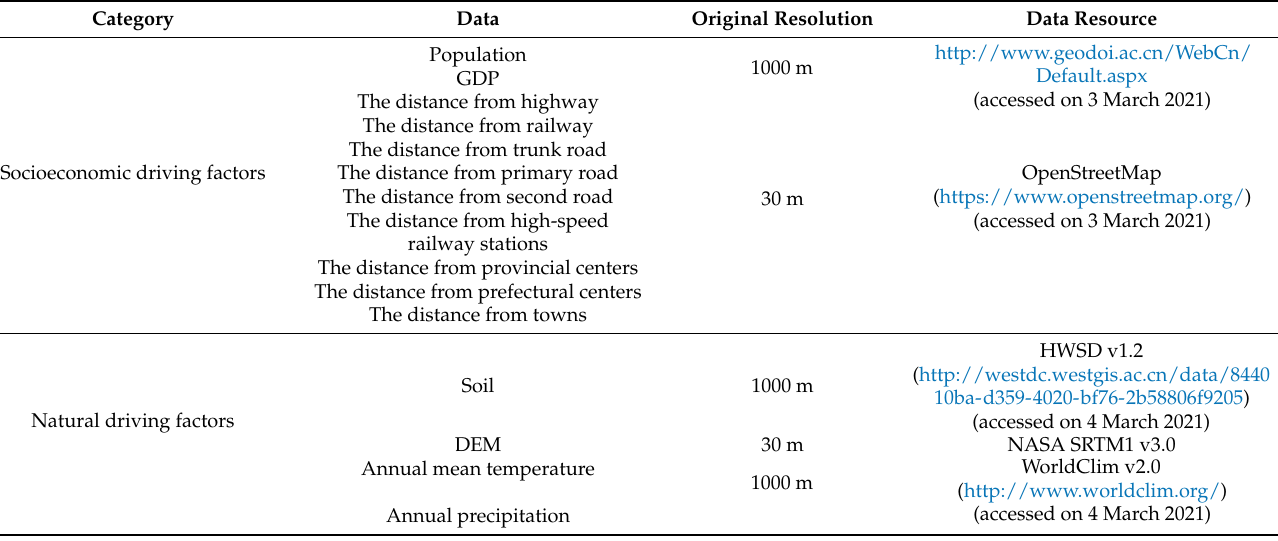
Table 2. The introduction of the driving